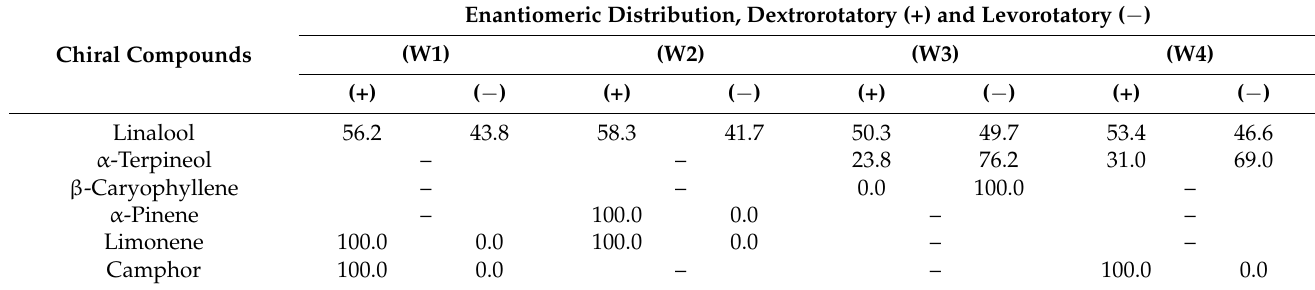
Table 8. Enantiomeric distributions of chiral terpenoids present in wintergreen essential oil based on geographical location; “–” indicates not detected; “+” indicates dextrorotatory.